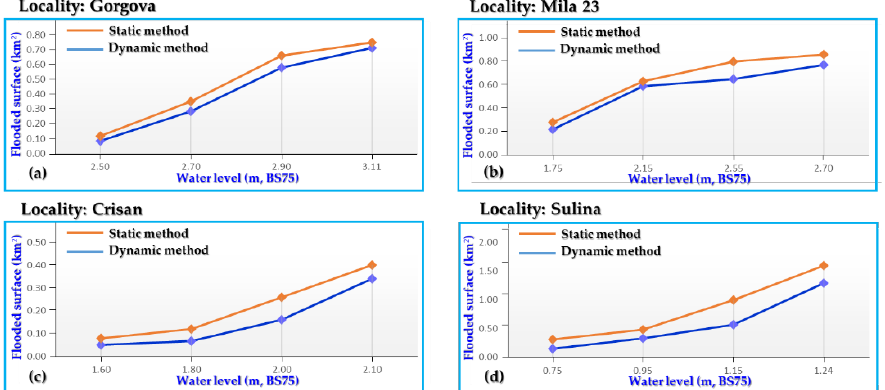
Figure 16. The differences of flooded area for the analyzed scenarios by using static method and dynamic method at: ( a )—Gorgova, ( b )—Mila 23, ( c )—Crisan, and ( d )—Sulina settlements. Referring to the first flood stage, the largest percentage differences between the two methods regarding the flooded area were observable for Vulturu (difference of 9.63%) and Maliuc (difference of 9.17%). The smallest percentage differences in the first flood stage were observable for Partizani (difference of 1.68%) and Gorgova (difference of 3.68%). For the second flood stage, the largest percentages, in terms of the differences regarding the flooded area, appeared in Ilganii de Sus (difference of 12.55%), Vulturu (difference of 16.85%), Maliuc (difference of 13.76%), and Crișan (difference of 10.44%), and the smallest difference was found in Mila 23 (difference of 4.30%). In the third flood stage, the largest percentage differences regarding the flooded area were recorded in the settlements of Crișan (difference of 21.89%) and Sulina (difference of 21.20%). At the same time, the smallest percentage differences were present in Partizani (difference of 9.46%), Ilganii de Sus (difference of 8.96%), Vulturu (difference of 9.63%), and Gorgova (difference of 9.83%).